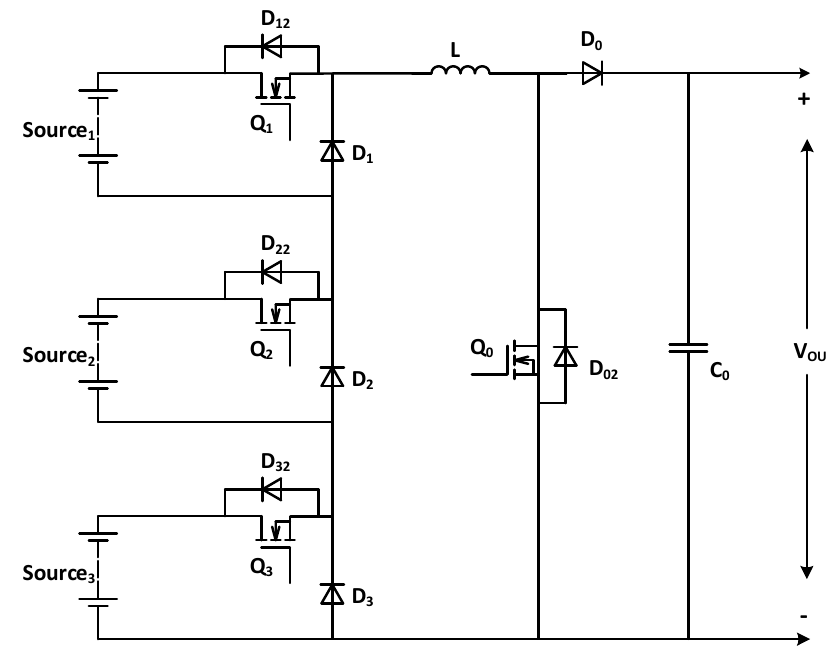
Figure 6. Structure of modular multiport system proposed.